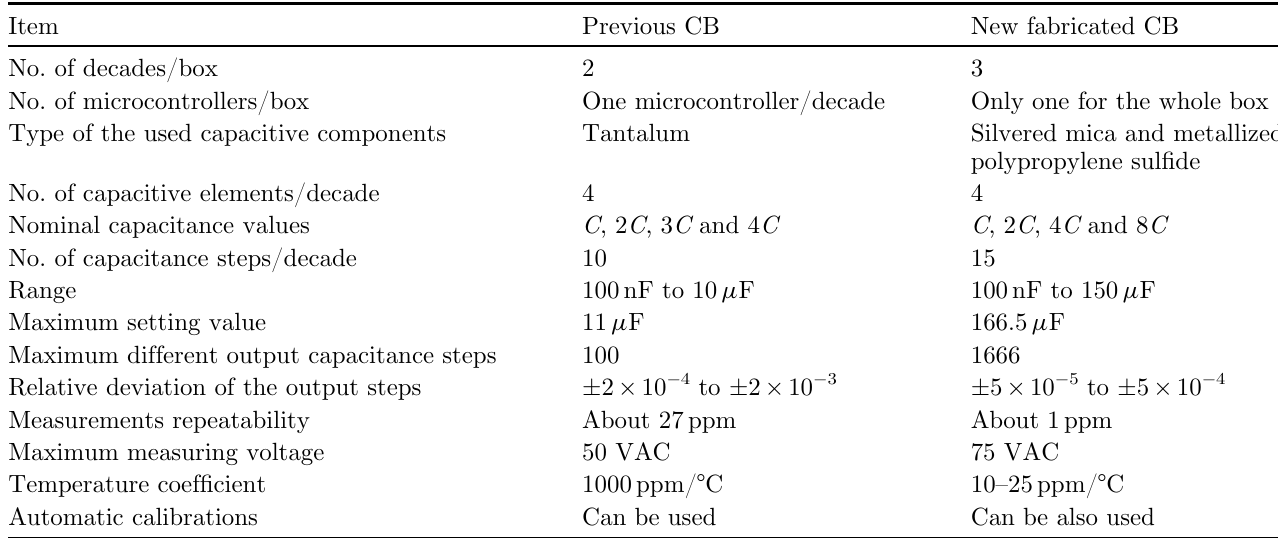
Table 4. Comparison between the previous CB and the new